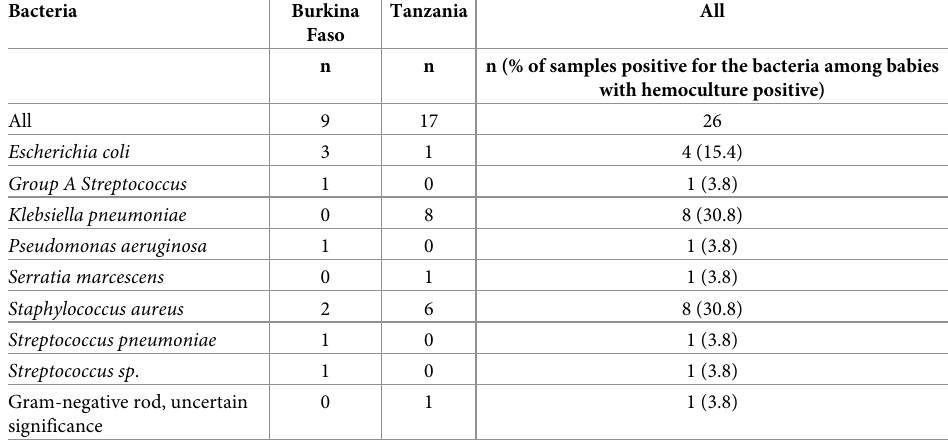
Table 6. Pathogens detected in hemoculture of young infants with clinically suspected invasive infection.